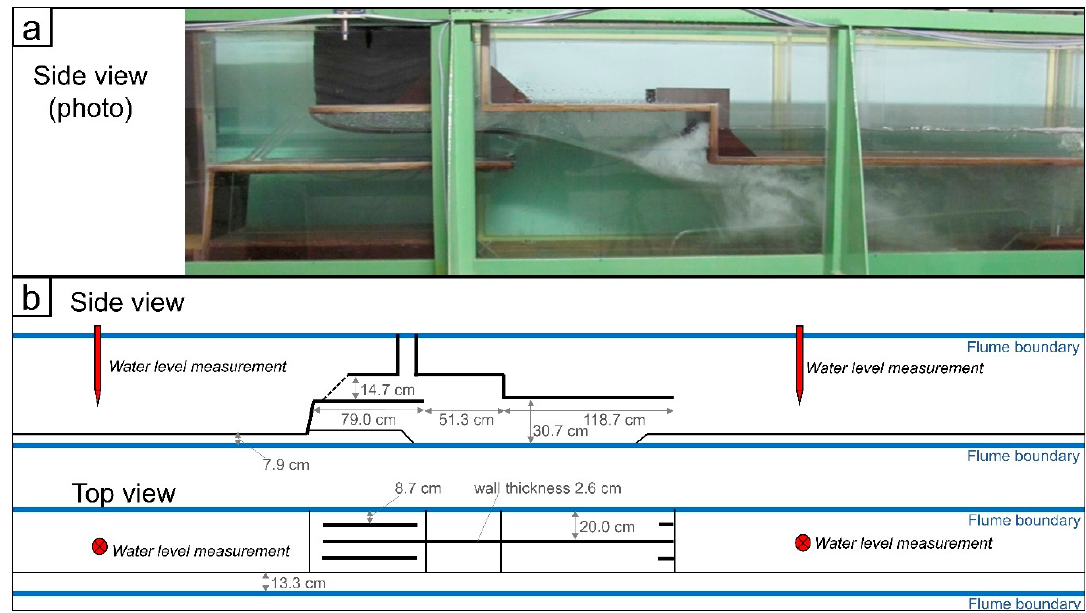
Figure 5. Side view photo of the actual scale model in the flume ( a ) and flume and scale model dimensions with side and top view plan ( b ). Water flows from left to right. Table 4. List of six sets of up- and downstream water levels for the scale model.